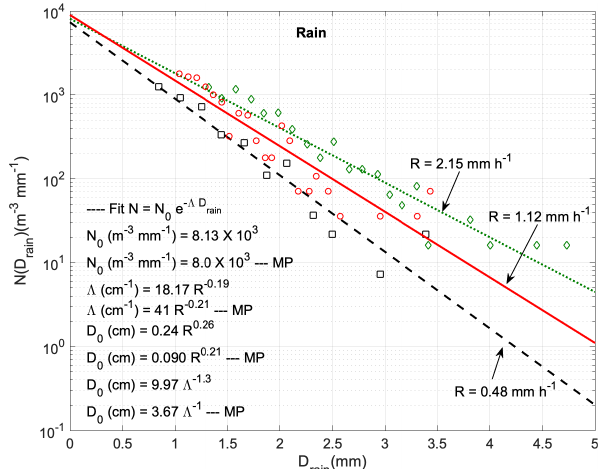
Figure 14. Size distributions of raindrops for different fall rates measured in Red Butte Canyon. Approximately 2000 raindrops were considered in each case and were binned in increments of ≈ 0 . 2mm. Distribution of raindrops (points) on a plot of log num- ber vs. diameter of raindrops ( D rain ), fitted using N(D rain ) = N 0 e − (cid:51)D rain (lines). R is the SWE rate of rainfall ( ˙ SWE), and D 0 is the median diameter of raindrops. Fitted results are compared with Marshall and Palmer (1948), abbreviated as